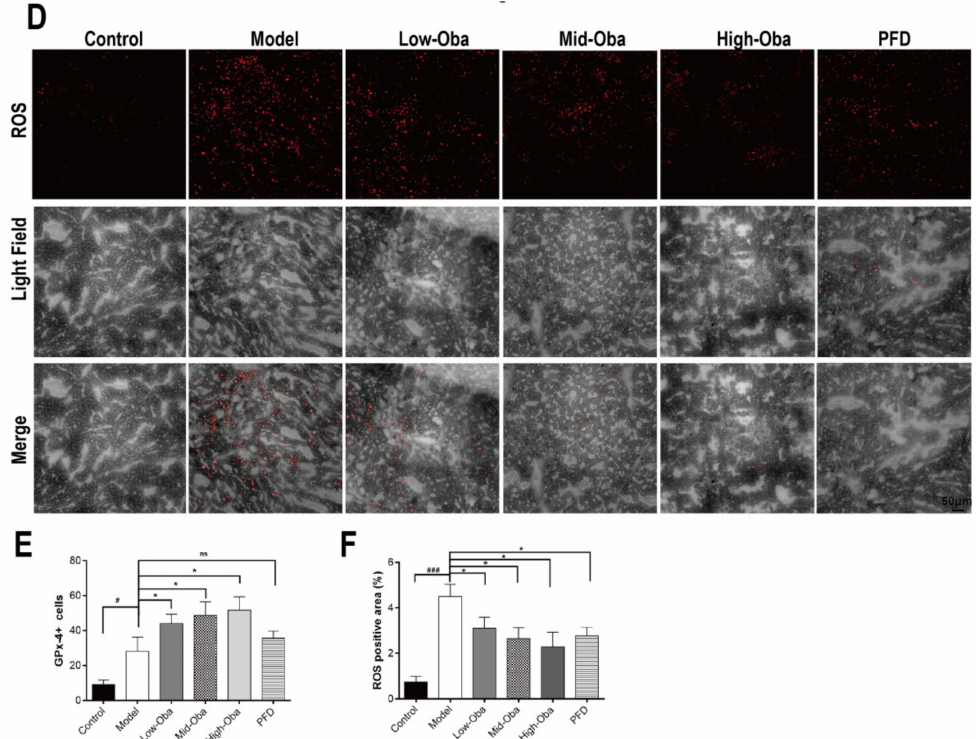
Figure 5. Oba improved the expression of GPx-4, decreased inflammation, and EMT-related protein expression and reduced the lipid oxidation level in CCl4-induced liver fibrosis. ( A ) Quantification of EMT-associated protein and IL-6 expressions as assessed by Western blotting in vivo. ( B ) Quantification of the Nrf-2 and GPx-4 expressions as assessed by Western blotting in vivo. ( C ) Immunohistologic staining for GPx-4 (brown) in the liver tissues. The cell nucleus was counter-stained with DAPI (blue). ( D ) ROS (red) staining by DHE. Tissues morphology of the mouse liver was observed under bright-field microscopy. ( E ) Statistics of the number of GPx-4 positive cells. ( F ) Statistics of ROS positive areas. The results were expressed as means ± SEM ( n ≥ 3). ns (italic), # , ## , ### indicate p > 0.05, p < 0.05, p < 0.01, p < 0.001 compare with control group; ns, *, ** indicate p > 0.05, p < 0.05, p < 0.01 compared with model